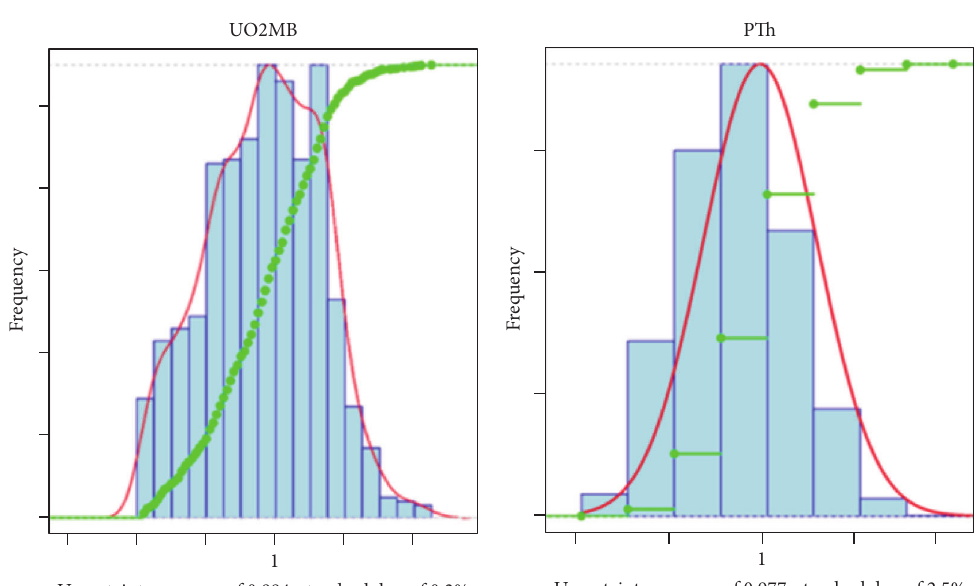
Figure 2: Statistical model of manufacturing